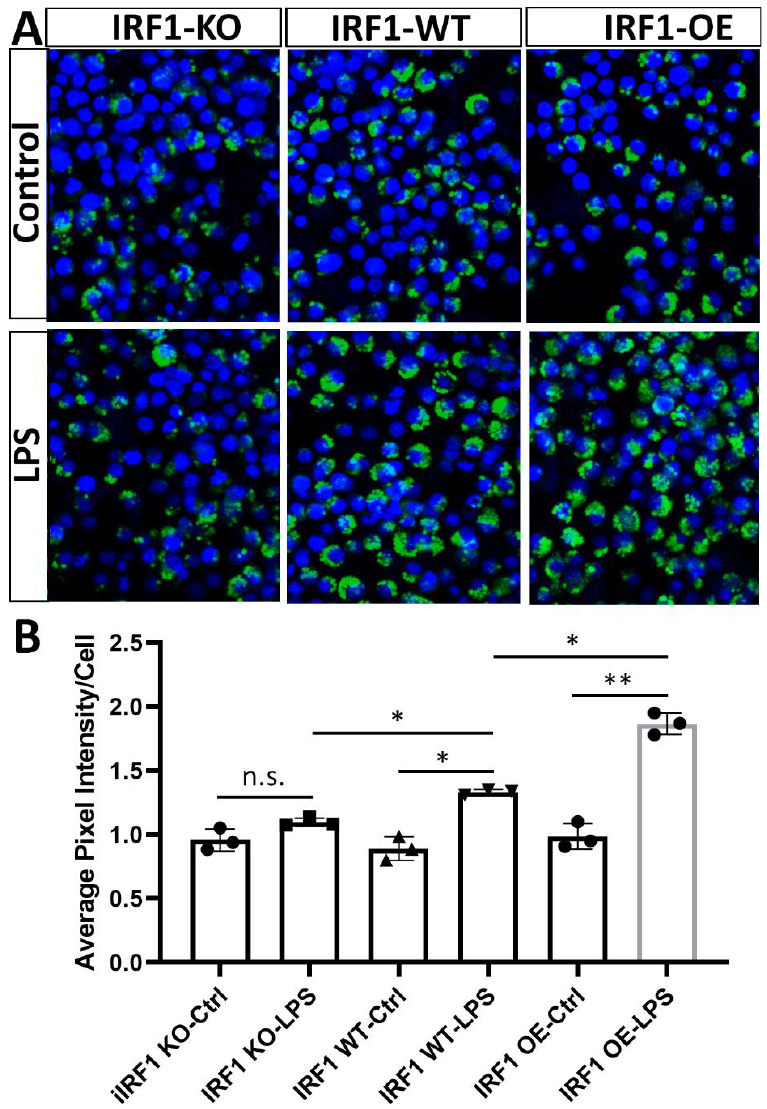
Figure 4. Phagocytosis evaluation of reactive microglia by Zymosan Bioparticles. Eighty percent confluent IRF1-KO, IRF1-WT, and IRF1-OE BV2 cells were treated with LPS (100 ng/mL) and PBS control for 24h. pHrodo TM Green Zymosan Bioparticles (0.5 mg/mL) were added and incubated for